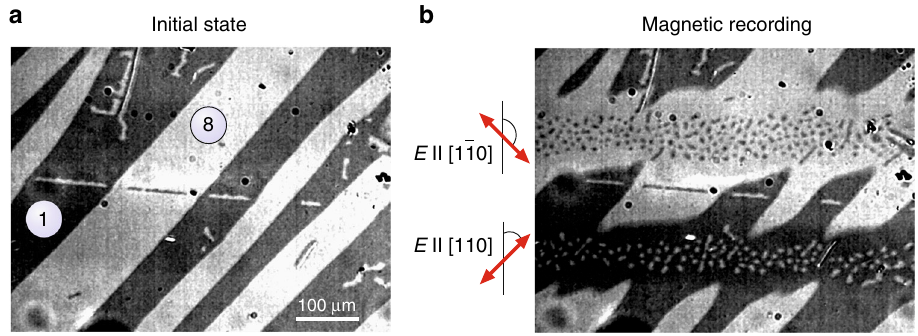
Fig. 2 Magnetic domains recorded by scanning polarized laser beam. a Initial domain pattern in YIG:Co fi lm. Large black and white stripes correspond to the domains with two orientations of the magnetization — 1 and 8 magnetization states in Fig. 1b. b The result of a scan with E || [110] polarized light ( ϕ = 45°) and E || [1 − 10] polarized light ( ϕ = 135°). The pump beam was focused to a spot with the radius r = 65 µ m. The scan velocity was 200 µ m s − 1 with 1000 pulses per second. The beam contains 50 fs laser pulses with the fl uence of 100 mJ cm − 2 . The central photon energy is 1.1 eV ( λ = 1140 nm). The recorded tracks are repeatable and stable for a long time at room temperature without external magnetic fi